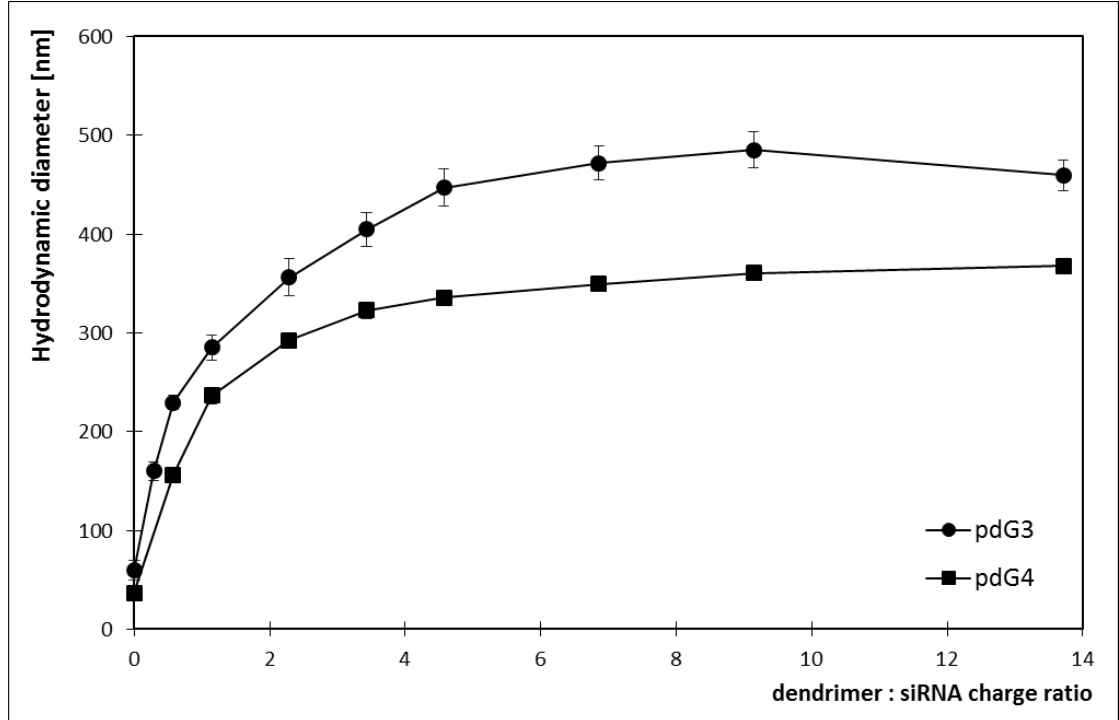
Figure 6. Changes in the hydrodynamic diameter of dendriplexes formed by